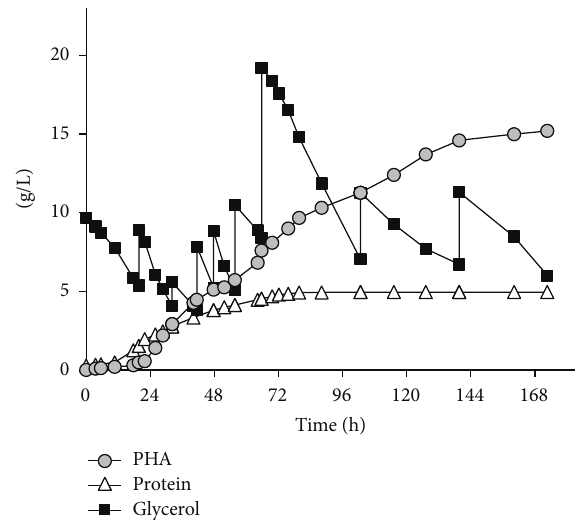
Figure 1: Fermentation pattern for PHA production on pure glycerol: time curves of substrate and